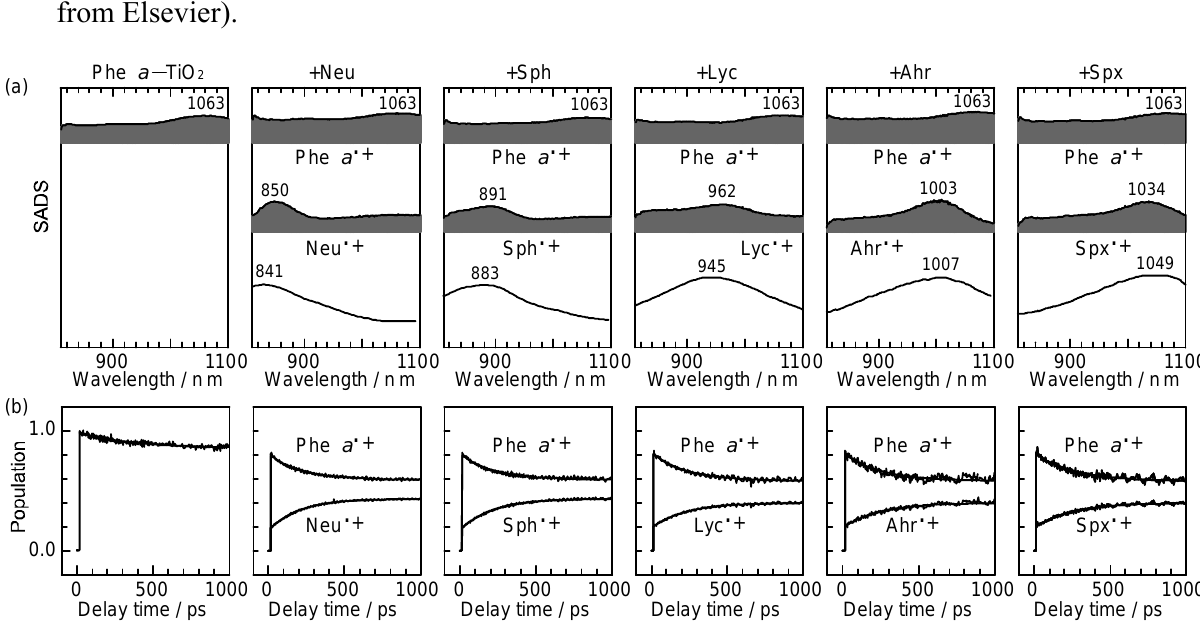
Figure 21. (a) SADS and (b) time-dependent changes in population, obtained by the SVD and global fitting analysis of the time-resolved data matrices in the 15 ps–1 ns region, for Phe a bound to TiO nanoparticles in suspension in the absence and presence of 10% each 2 of neurosporene, spheroidene, lycopene, anhydrorhodovibrin and spirilloxanthin. The absorption peak of each Car • + free in solution electrochemically generated, is presented as a line spectrum for comparison (reprinted from [17], Copyright (2005), with permission from Elsevier).